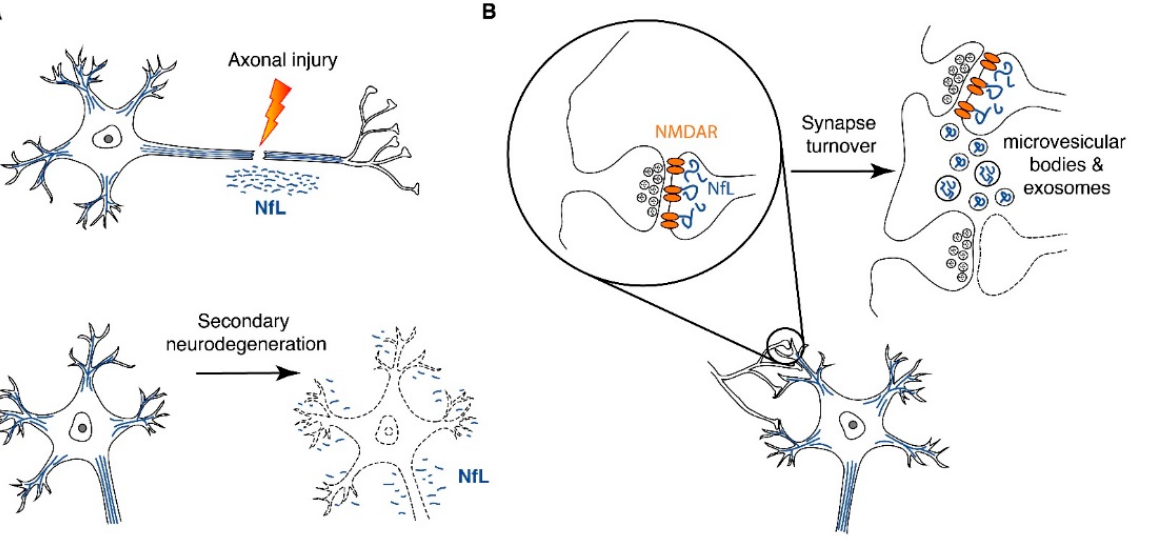
Figure 2. NfL release from neurons after stroke. ( A ) NfL (or NfL-derived peptides) can be released from neurons to the extracellular space as a consequence of direct axonal injury or secondary neurodegeneration. ( B ) NfL plays important role in regulating neurotransmission and other aspects of synaptic function. Microvesicular bodies or endosome-derived exosomes were proposed as hypothetical routes of the active release of NfL or NfL-derived peptides from neurons. NfL release by neurons may reflect synaptic turnover and adaptive plasticity. The exact mechanisms through which NfL or NfL degradation products reach the cerebrospinal fluid and the blood compartment are not known, but the intramural peri-arterial drainage pathway [35] and the glymphatic system [36] that drain peptides and proteins from the extracellular space of the brain to the lymphatic system and blood present conceivable